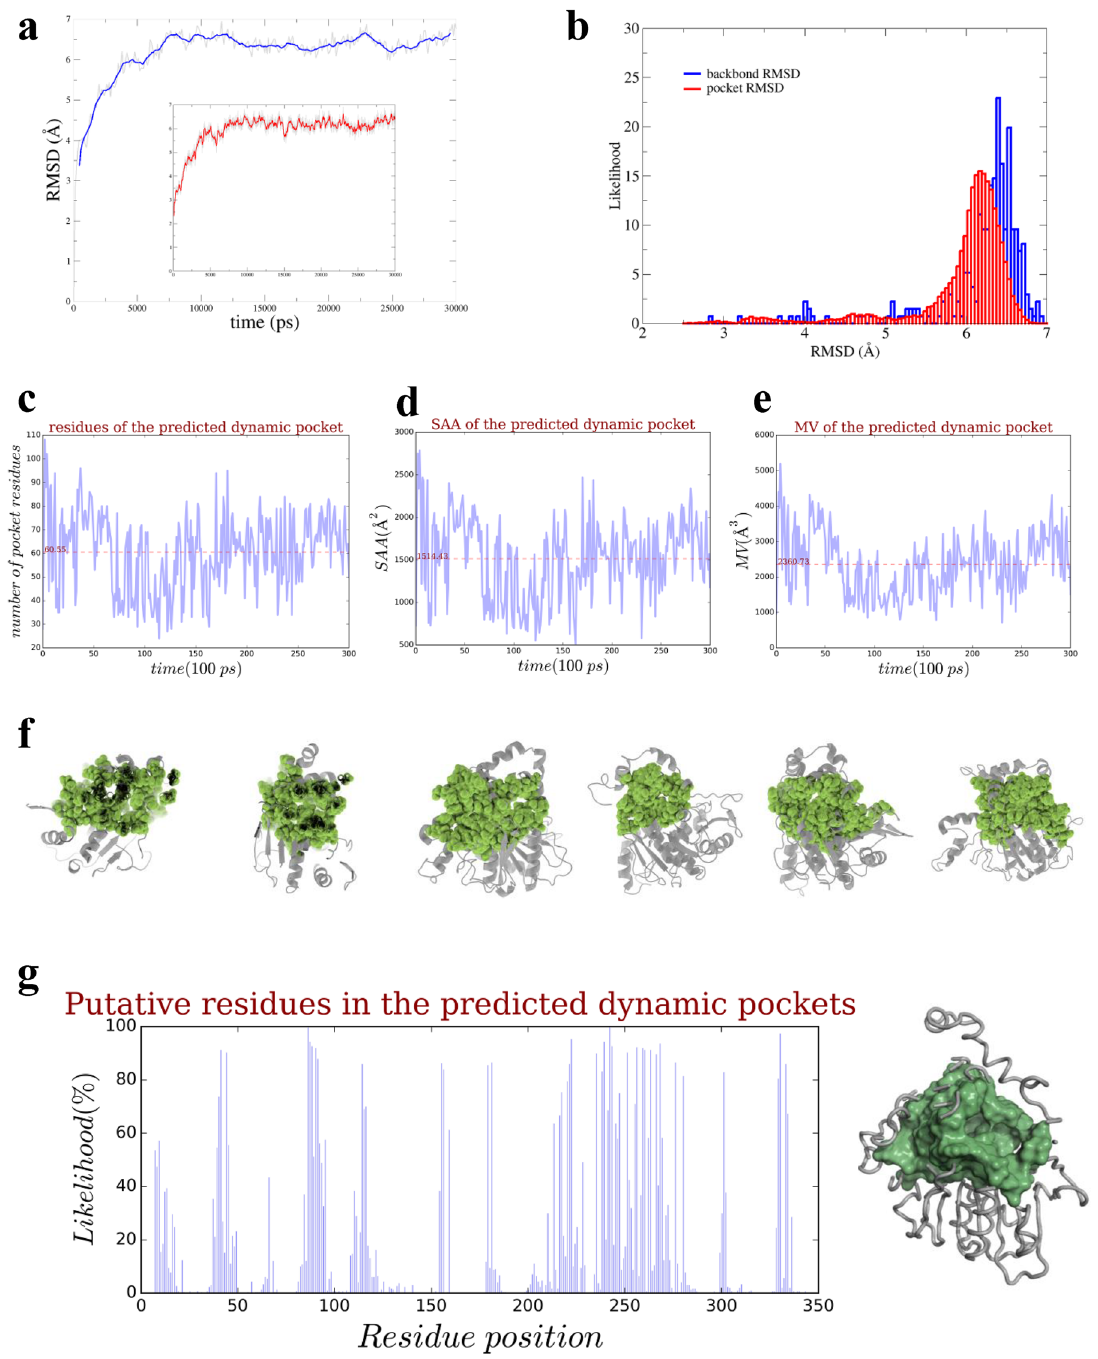
Figure 1. Assessing the dynamic surface of ABHD5 in MD simulations. ( a ) During MD simulations of 30 ns, ABHD5 dynamic conformations in a trajectory were sampled and refined. The backbone (global) and predicted main binding pocket (local) of RMSD values range within 7 Å. Their RMSD distributions of backbone (blue) and binding-pocket (red) were computed in ( b ) with a mean of 6.2 Å and 5.9 Å, respectively. The trivial difference of RMSD indicates that the binding pocket reshapes along with the conformation of the backbone. In each 100 ps step, the geometric measurement of the dynamic pocket was assessed, including the mean number (61 amino acid residues) of pocket residues in ( c ), its mean molecular volume (MV, 2360 Å 3 ) in ( d ) and mean solvent accessible areas (SAA, 1514 Å 2 ) in ( e ) during simulations. In structural analysis of structural alignment on the 300 conformers, classification was performed based on the customized cutoffs with incremental decreases from 3.5 to 1.5 Å of RMSD. Six subclasses were classified for shape analysis. For each of subclasses, a representative in ( f ) with the middle RMSD was selected with its identified binding pocket (green). Each residue of ABHD5 was assigned with a probability of appearing as a pocket residue on the dynamic surfaces (green) of the 300 conformers. ( g ) How a pocket residue emerged from a residue on the surface or vice versa is recorded in the dynamic conformers. By identifying the geometric locations of a residue in all 300 conformers, the likelihood of a pocket residue is computed for dynamically occupying a pocket in the